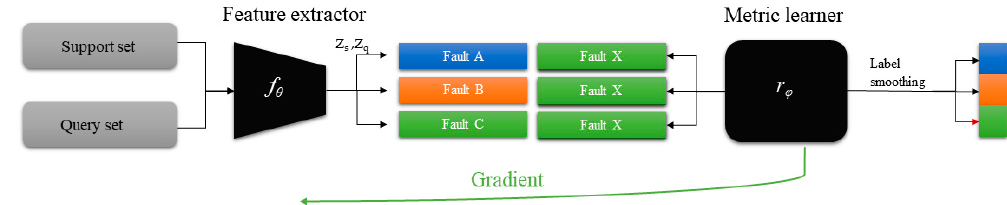
Figure 4. Learning procedure of few-shot meta learning with the episodic training strategy.